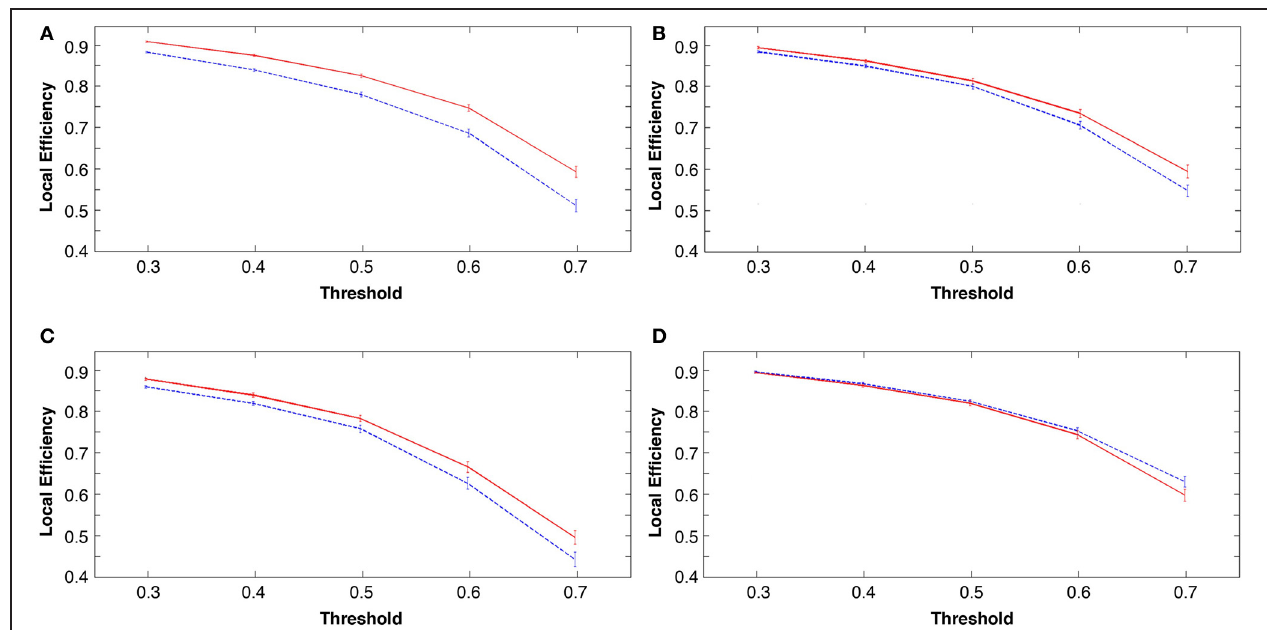
FIGURE 6 | Group mean local efficiency at all costs before and following the four tasks, in all figures rest 1 (pre-task in blue) and rest 2 (post-task in red). (A) explicit SRTT (B) implicit SRTT